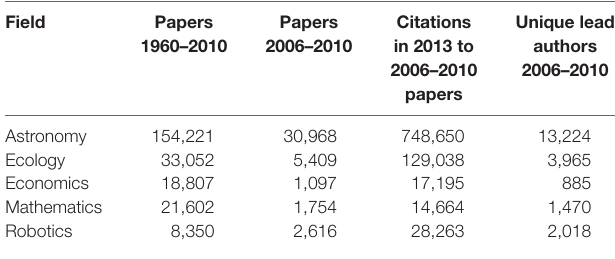
Table 1 | summary of the data used in this